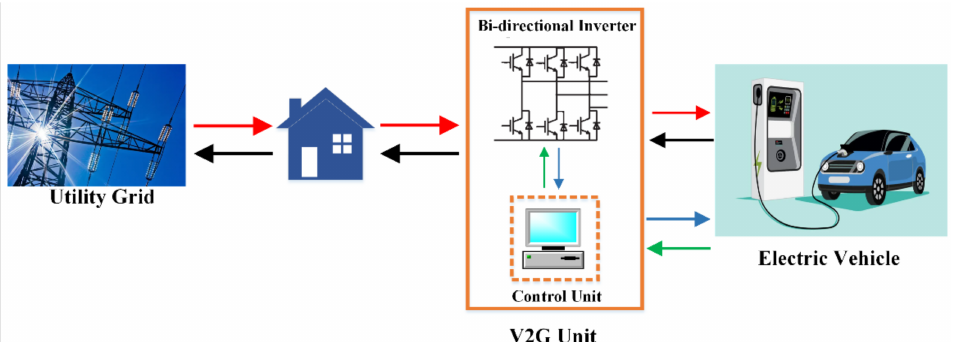
Figure 6. Electric vehicle as a source of